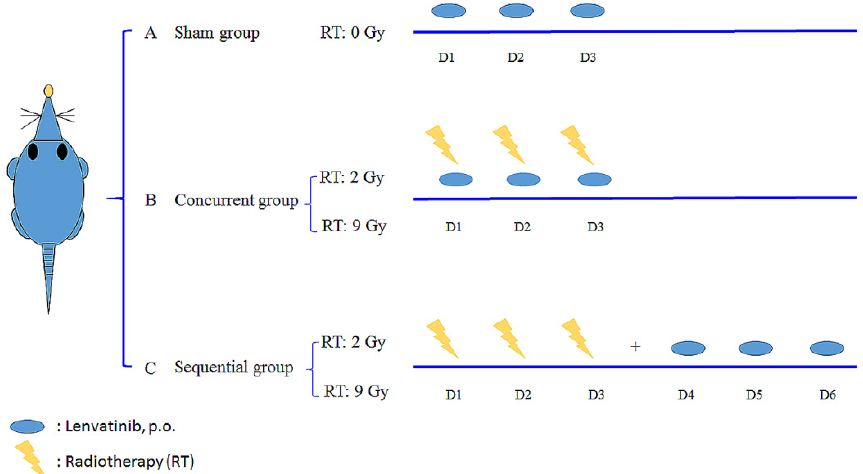
Figure 2. Oral lenvatinib [3 mg/kg per os (p.o.), quaque die (q.d.)] with radiotherapy (RT) under different time schedules and RT doses. The rats were randomly divided into a sham group, lenvatinib (p.o., q.d. × 3 d) with RT 0Gy (lenvatinib ×3d ); a concurrent group, lenvatinib ×3d 1 h after RT 2Gy in 3 fractions (RT 2Gy×3f’x ) and RT 9Gy×3f’x ; and a sequential group, lenvatinib ×3d 24 h after RT 2Gy×3f’x and RT 9Gy×3f’x . Data are expressed as the mean ± standard error of the mean.